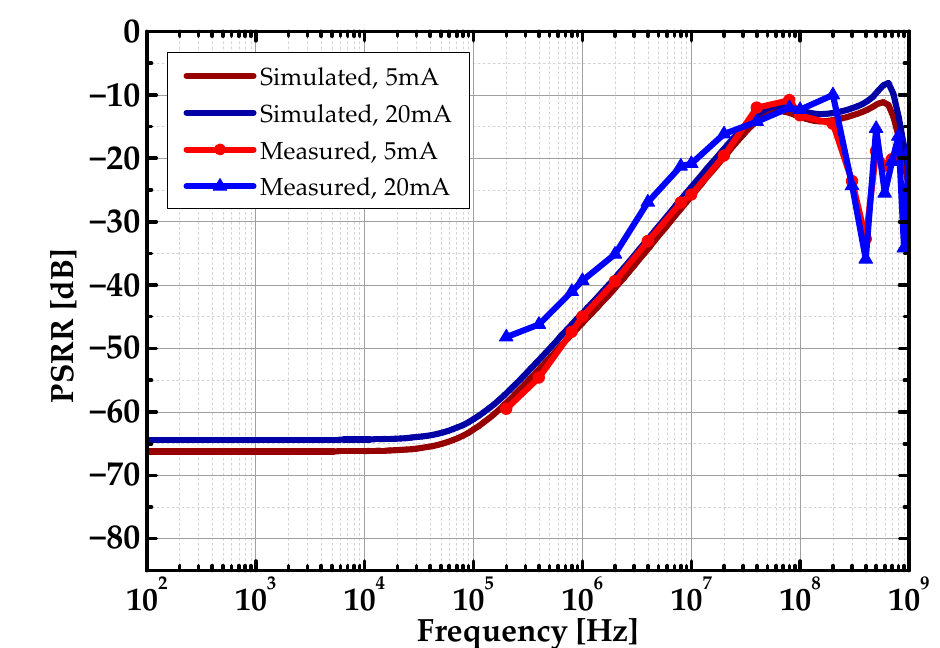
Figure 11. Simulated and measured PSRR of the FVF LDO.